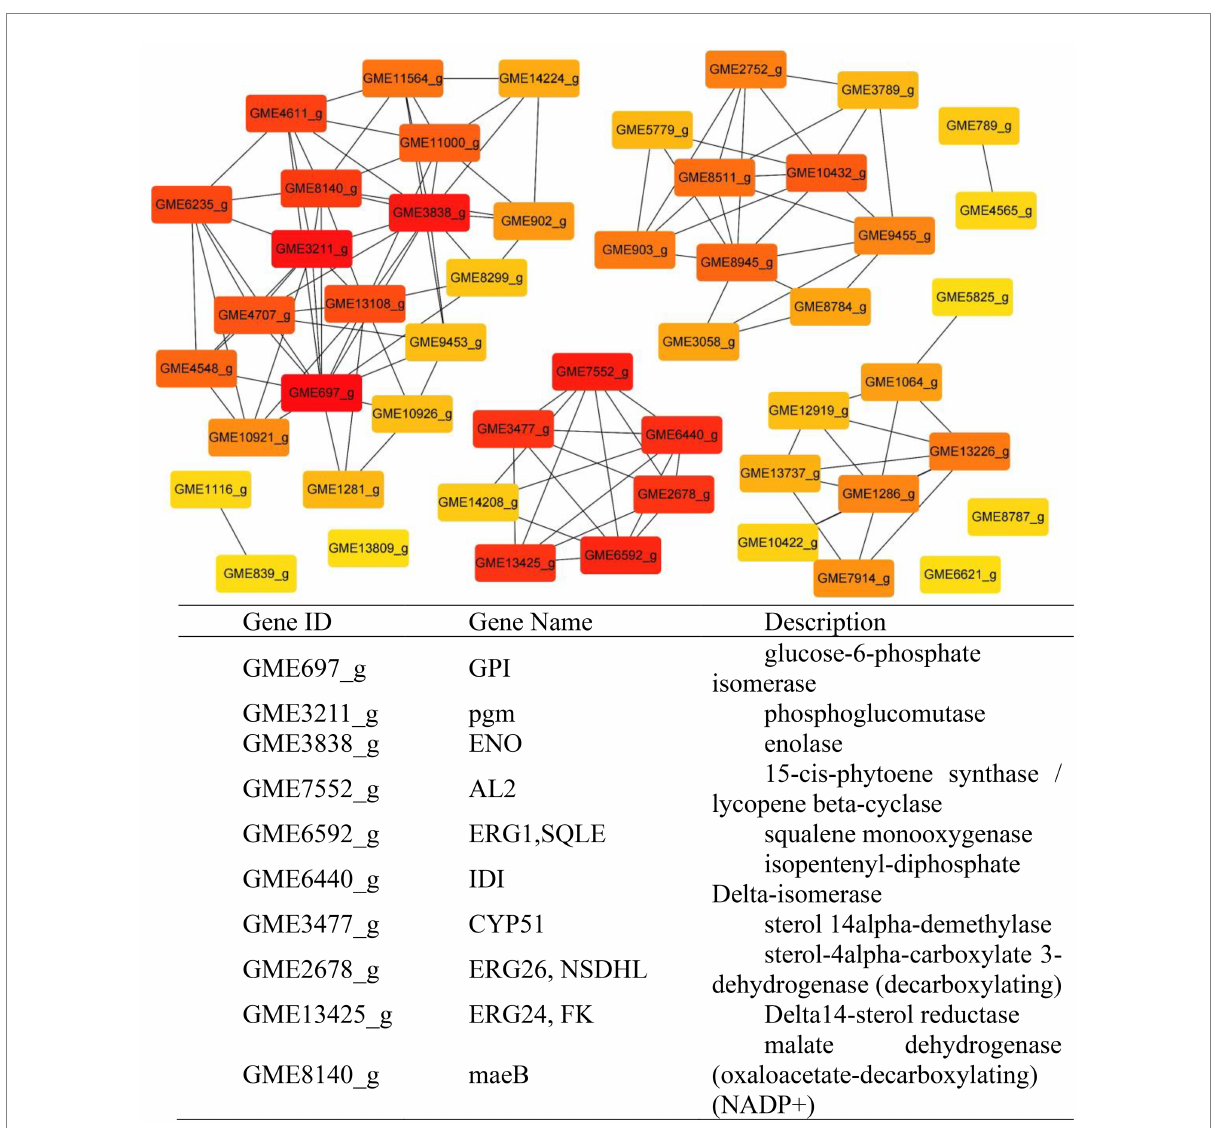
FIGURE 10 Protein–Protein Interaction network. Dark notes represent hub